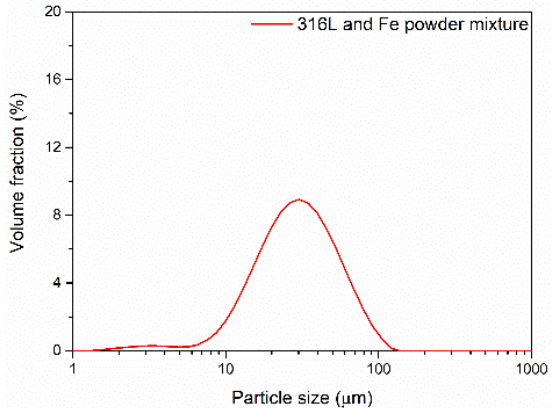
Table 4. Particle size distribution of unmixed and mixed (hybrid)